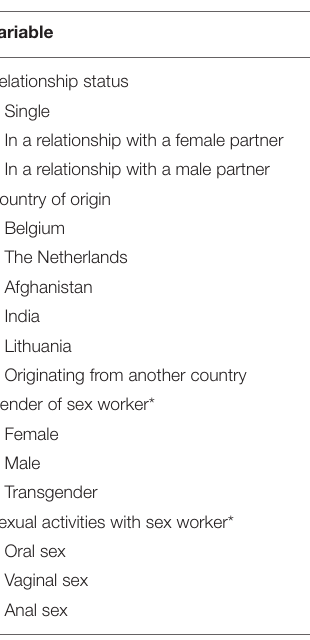
TABLE 1 | Overview of demographic information of participants.